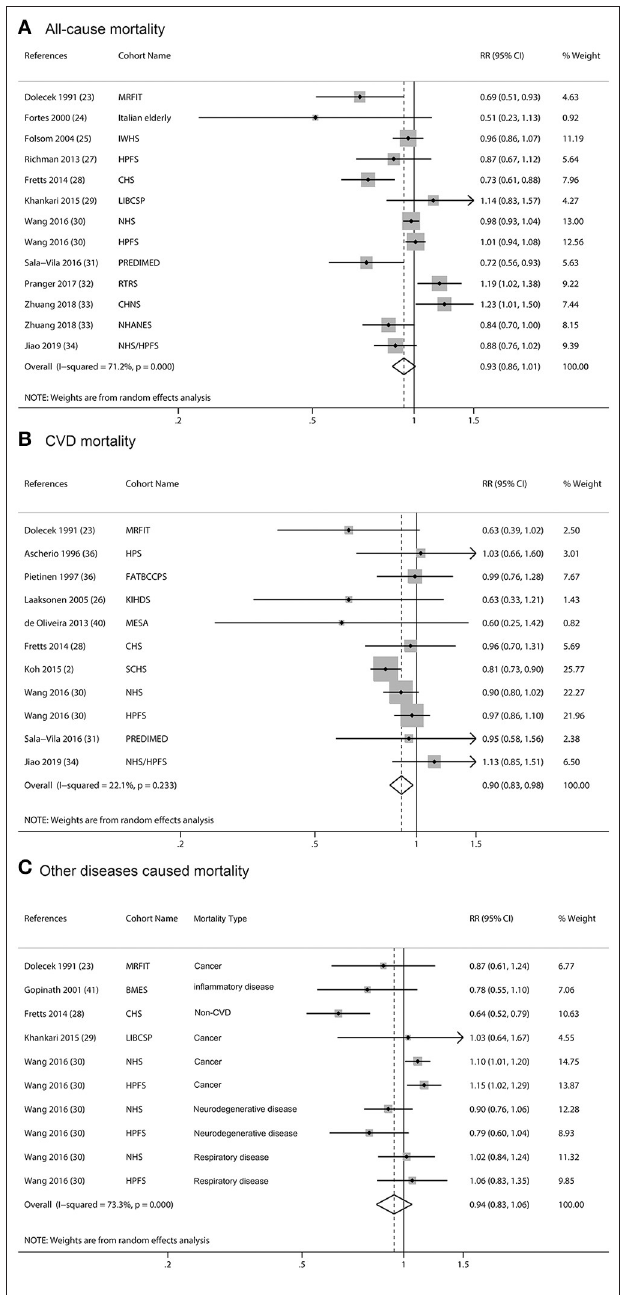
FIGURE 2 | Meta-analysis of the associations between dietary α - linolenic acid (ALA) intake and mortality from all cause (A) , cardiovascular disease (CVD) (B) , and other diseases (C) in prospective cohort studies. CI, confidence interval. The horizontal lines denote the 95% CIs, some of which extend beyond the limits of the scales. The square is proportional to the weight of each study. The diamond represents the overall pooled estimate of the relative risk.